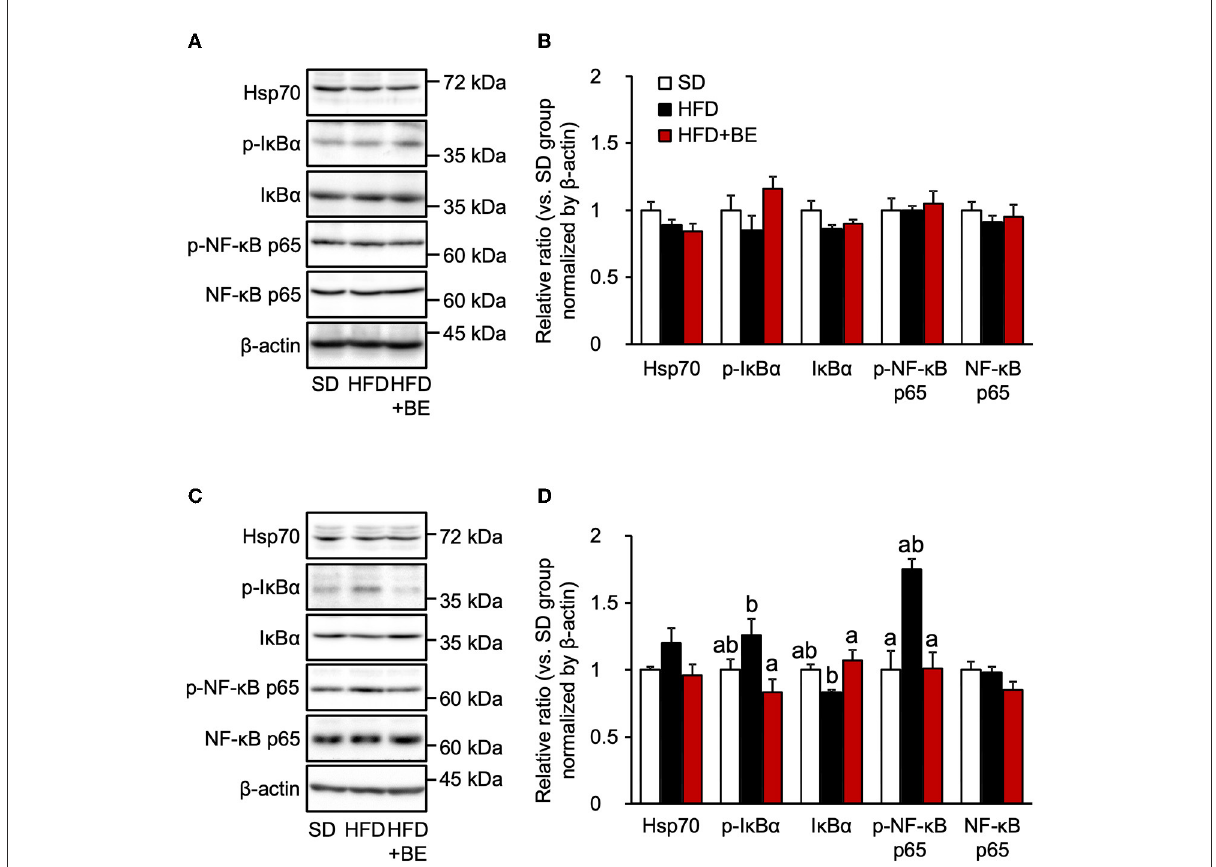
FIGURE3 Western blotting analysis of the effects of BE on the expression of proteins involved in the NF- κ B pathway. (A,C) Expression of 70 kDa heat shock protein (Hsp70), phosphorylated inhibitor of nuclear factor-kappa B alpha (I κ B α ), I κ B α , phosphorylated nuclear factor kappa-B p65 subunit (NF- κ B p65), NF- κ B p65 and β -actin in the whole hypothalamus extracts of mice on (A) Day 3 (3d) and (C) Week 4 (4w) of the feedings. (B,D) Quantification of the expression levels of proteins in the whole hypothalamic fractions shown in (A,C) , respectively. Data shown are mean ± SE ( n = 5). Different letters represent significant differences among the three groups at each experimental period by Tukey-Kramer honestly significant difference test ( p < 0.05).